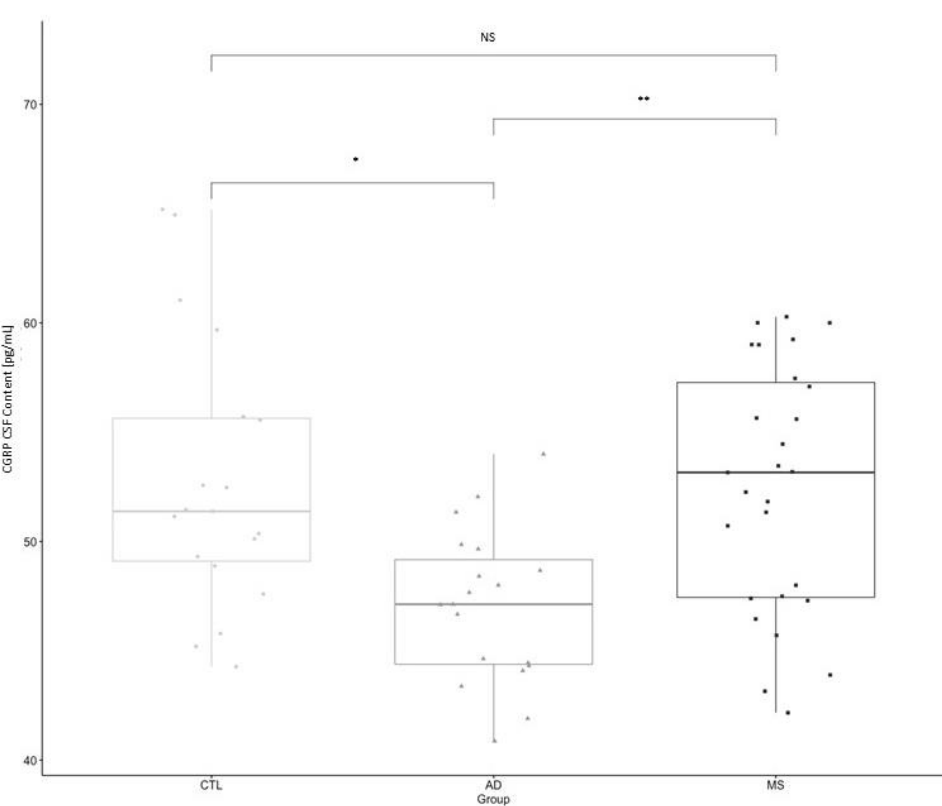
Figure 1. Comparison of the mean CSF concentration of α -CGRP between Control Subjects, Alzheimer Disease and Multiple Sclerosis. Legend: *: p = 0.008 from One-Way ANOVA (Alzheimer’s Disease vs. Controls); **: p = 0.004 from One-Way ANOVA (Alzheimer’s Disease vs. Multiple